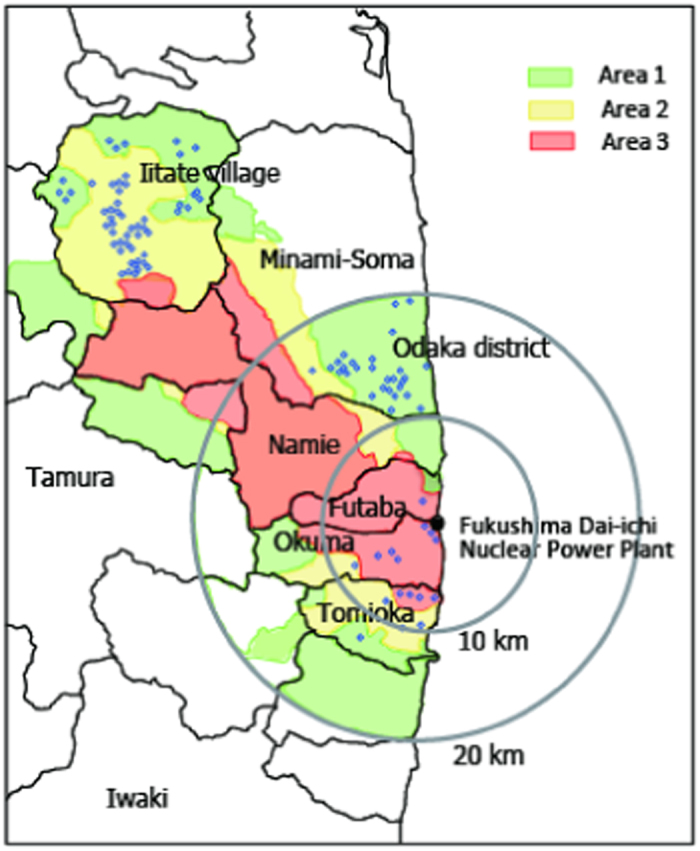
Map of the measurement locations and evacuation areas (October 1, 2014).The locations of the measurements are shown as blue circles. One blue circle indicates one house investigated at each location. The map was created using Microsoft Power Point software (version 14.4.5).